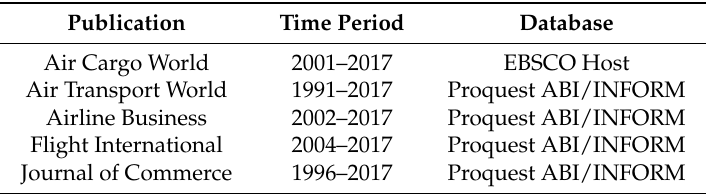
Table 1. Publication, time-period, and database source used in the